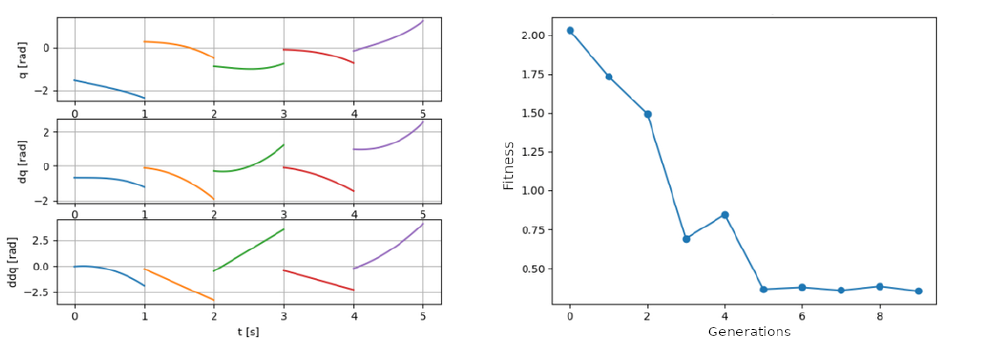
Figure 8. The behavior of the algorithm for the boundary condition set to 0.1. The best-achieved solution is visualized on the ( left ), and the fitness change through generations is on the ( right ). When the boundary condition is set to the value of 0.05, the graphs given in Figure 9